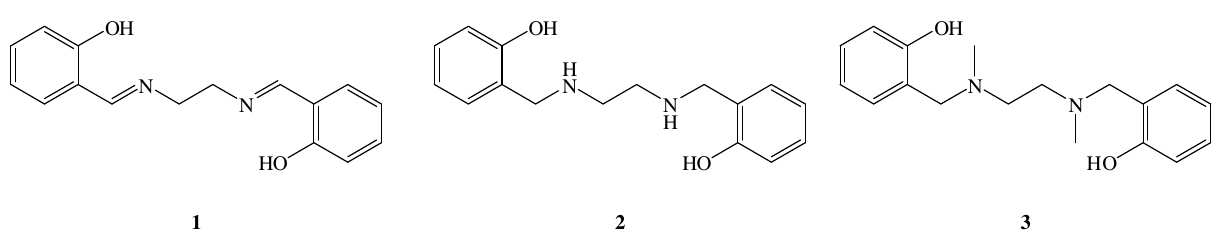
Figure 1. Structures of compounds 1-3